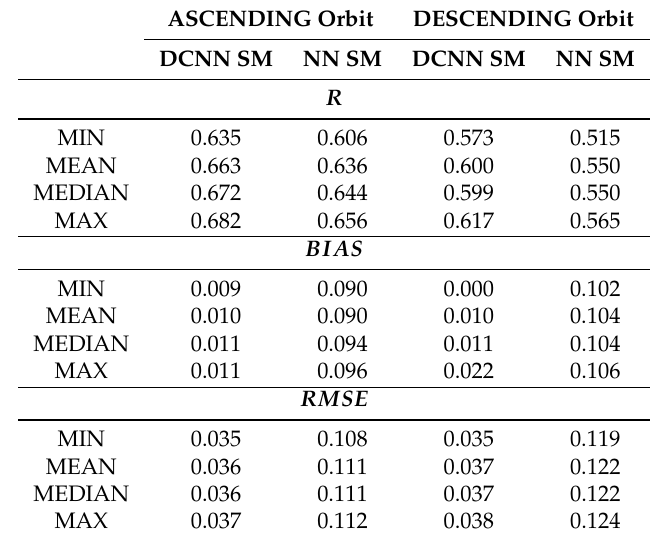
Table 2. The min, mean, median and max values of R , BIAS , RMSE between DCNN/NN SM and ERA-Interim SM in the testing phase. Data from ascending and descending orbits are processed